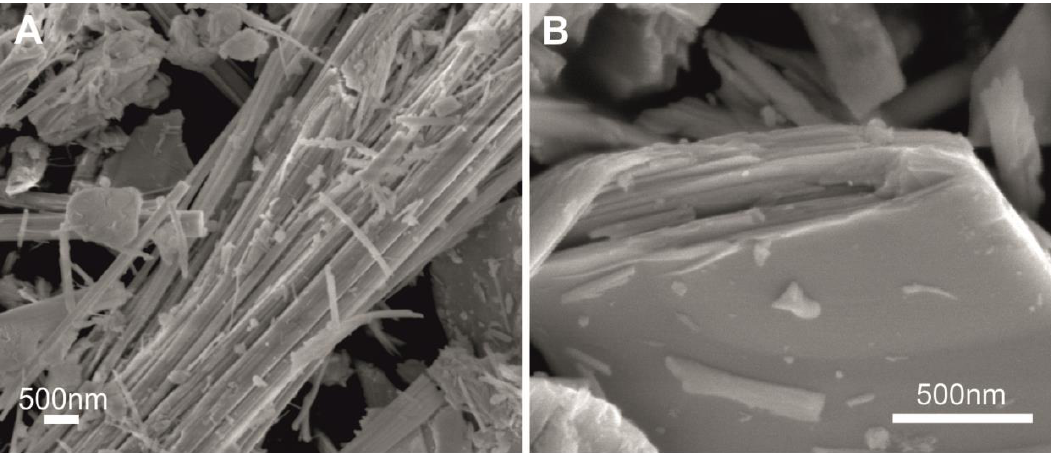
Figure 3. SEM images of ( A ) HLaTa_01 and ( B ) HLaTa_02 perovskites obtained by protonation of RbLaTa-based starting materials.